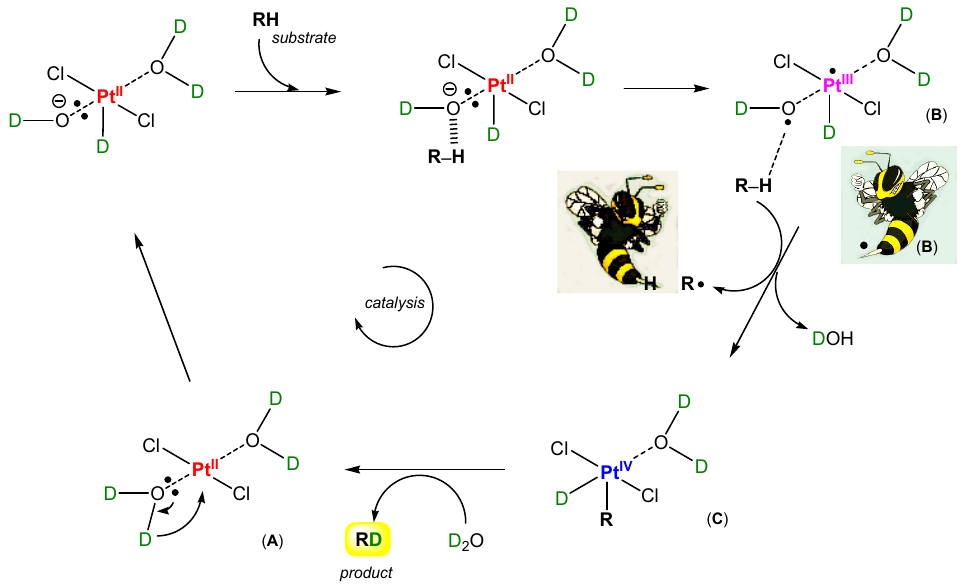
Figure 21. A hypothetical “wasp’s sting mechanism” of the first step of Shilov chemistry (interaction between methane and Pt II Cl 42 − ). between methane and Pt II Cl 42 ´